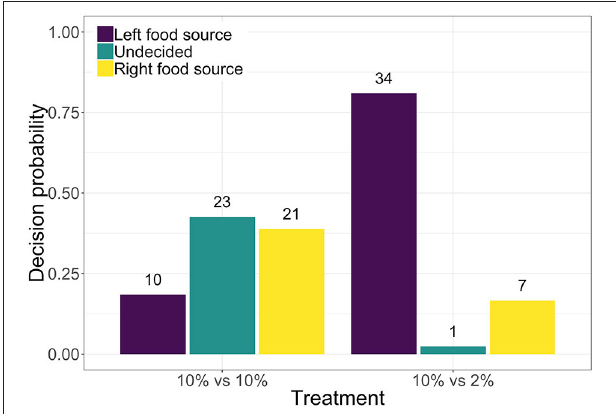
FIGURE 2 | Distribution of final decisions (i.e., left food source, undecided, or right food source) taken by P. polycephalum tubules for the symmetric food choice condition with two 10% w/v oat-agar blocks (54 experimental trials with both left and right food sources being 10% w/v oat-agar food block) and the asymmetric food choice condition with 10% w/v and 2% w/v oat-agar blocks (42 experimental trials with left food source being 10% w/v oat-agar food block and right being 2% w/v oat-agar food